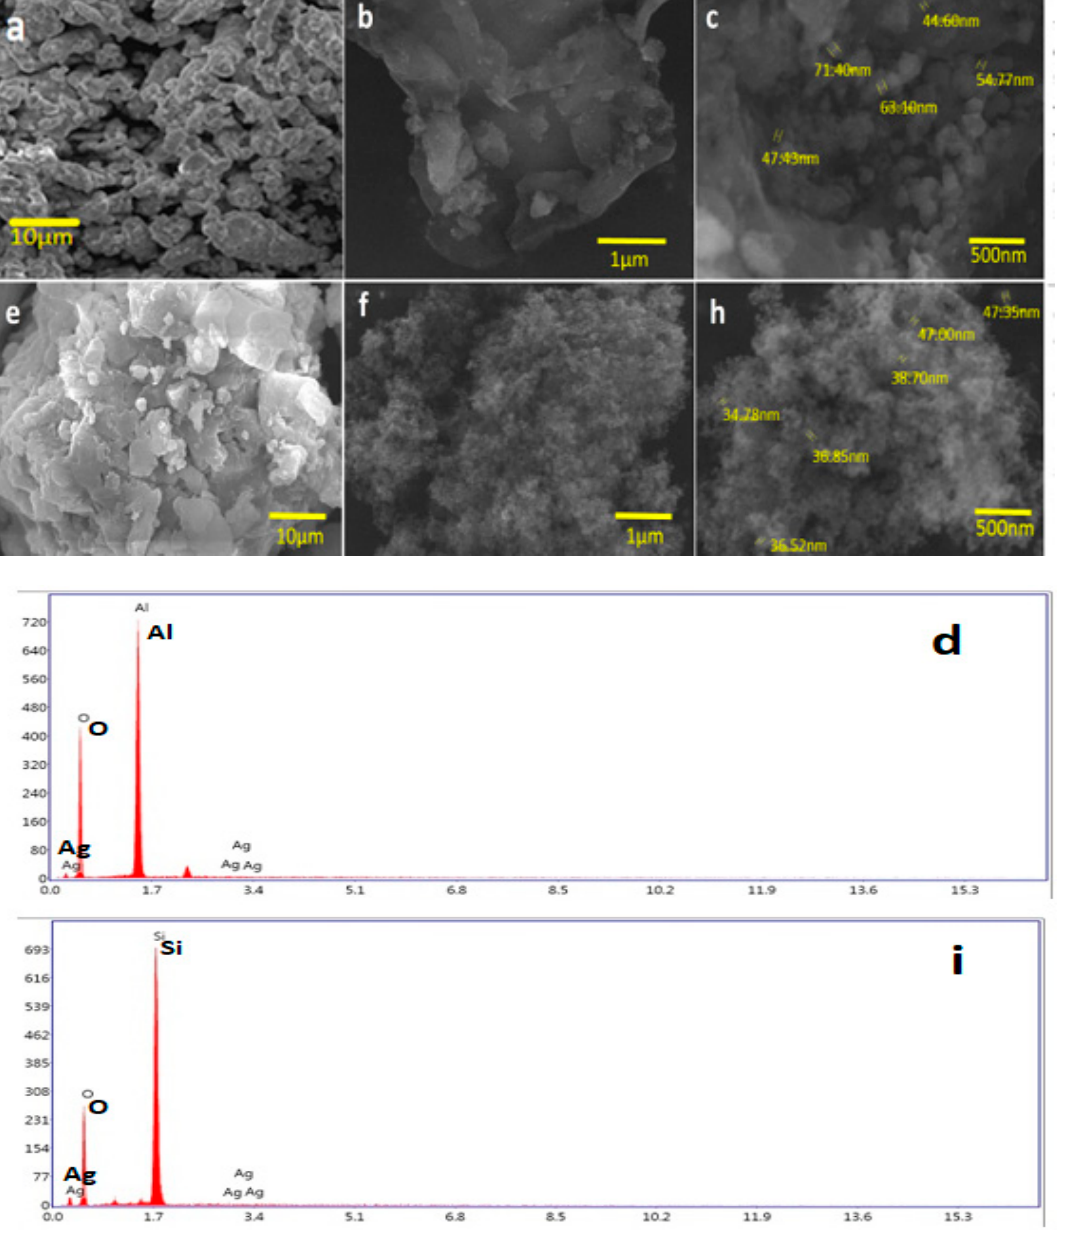
Figure A6. SEM images in different magnifications of ( a – c ) Ag loaded Al 2 O 3 NPs and ( e , f , h ) Ag loaded SiO 2 NPs. EDS of ( d ) Ag loaded Al 2 O 3 NPs and ( i ) Ag loaded SiO 2 NPs. SEM images (Figure A6e,f,h) and EDS (Figure A6i) of Ag loaded SiO 2 NPs inform the morphology, particle size and elemental composition of Ag loaded SiO 2 NPs. SEM images (Figure A6f,h) reveal that the particles are predominantly spherical with particle sizes ranging from 34 nm to 47 nm. EDS (Figure A6i) reveals the elemental composition in weight % for oxygen, silicon and silver as 55.11, 44.61 and 0.29, respectively.